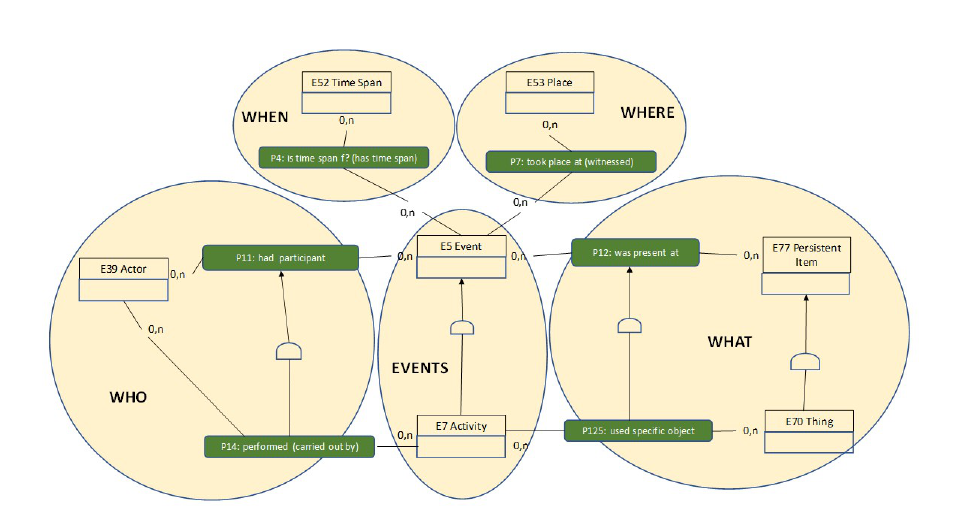
Figure 3. CIDOC-CRM